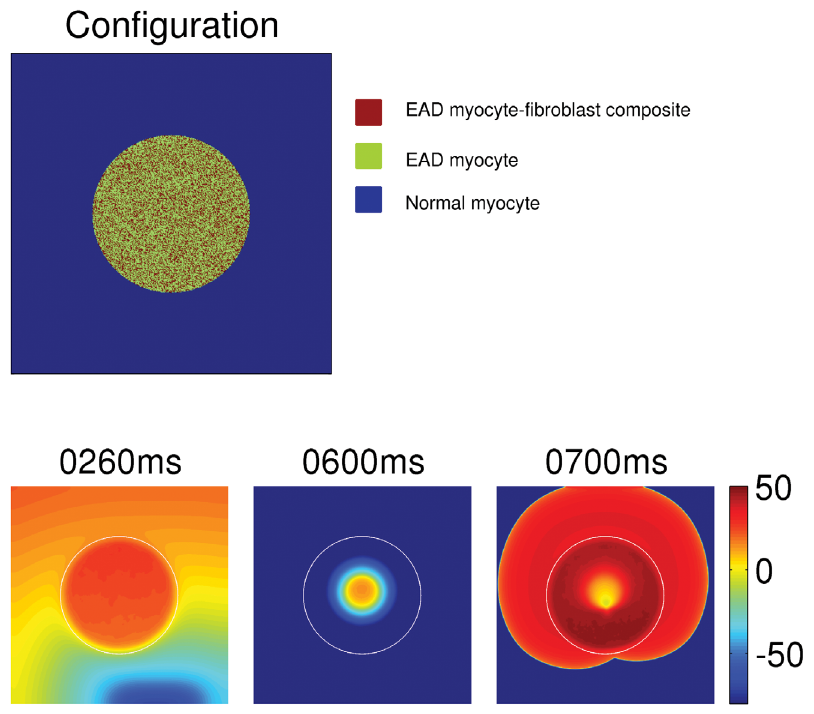
respectively, an EAD myocyte-fibroblast composite, an EAD myocyte, and a normal myocyte. The bottom panel shows the triggering of PVCs by the clump with the above configuration of